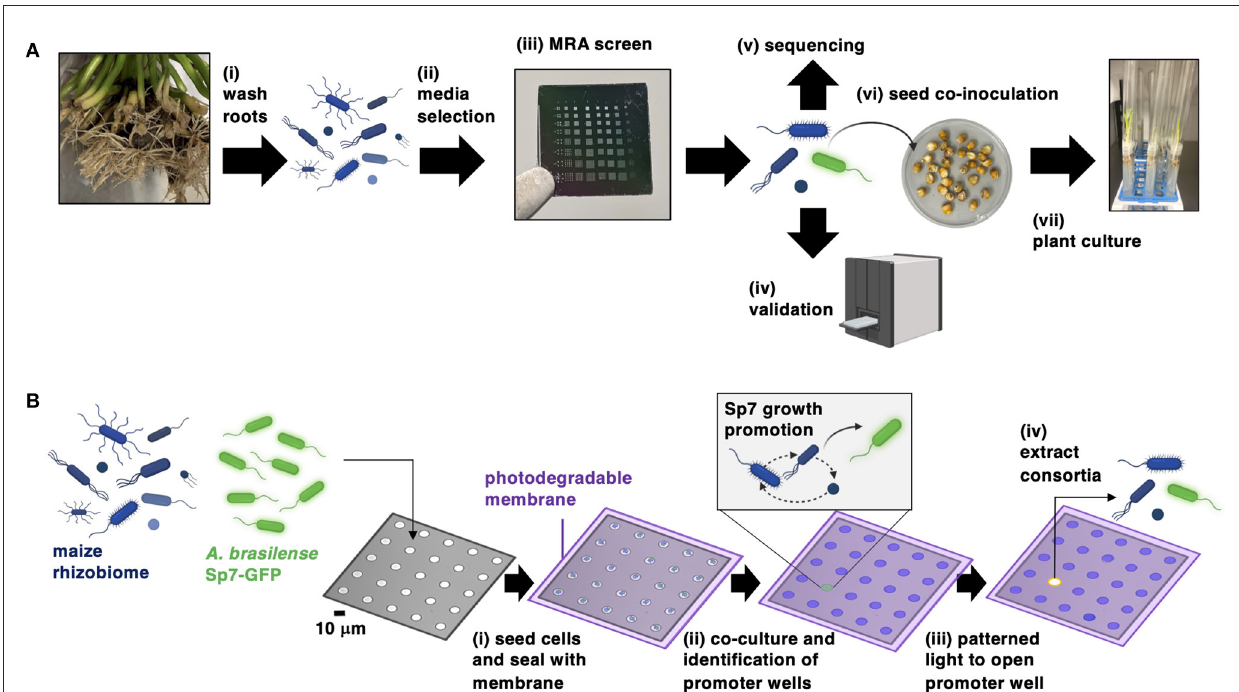
FIGURE1 (A) Workflow for bioprospecting the maize rhizosphere for isolates (blue cells) that improve the colonization of Sp7 (green cells) in maize roots. (B) Operational steps of the MRA device for screening and isolating consortia from the maize rhizosphere that promote the growth of Sp7. Figure was prepared with the assistance of BioRender